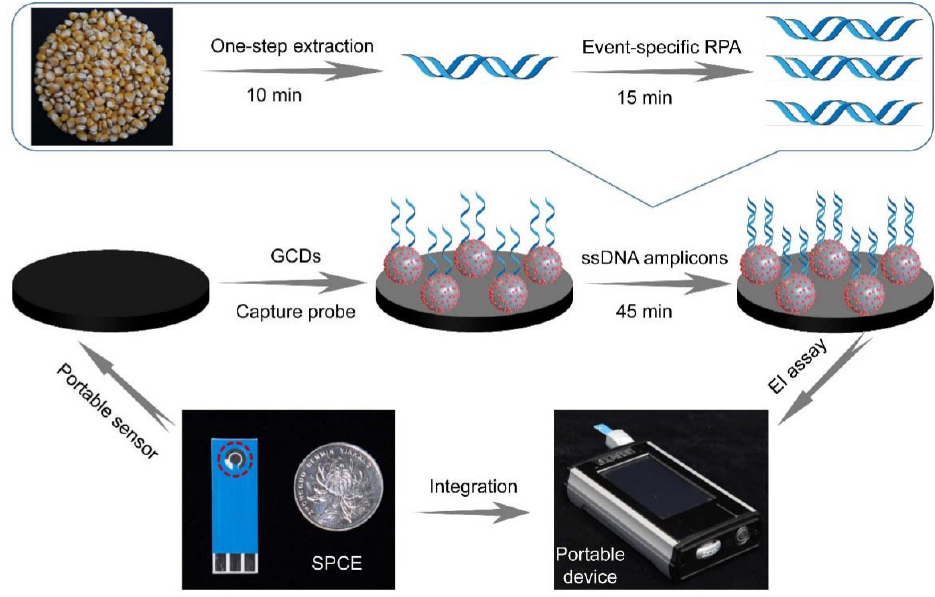
Figure 17. Fabrication process of EI gene sensor based on GCD (Reprinted with permission from Ref. [73]. 2022, Cui et al.). Table 8. Electrochemical biosensors for the detection of GMC.